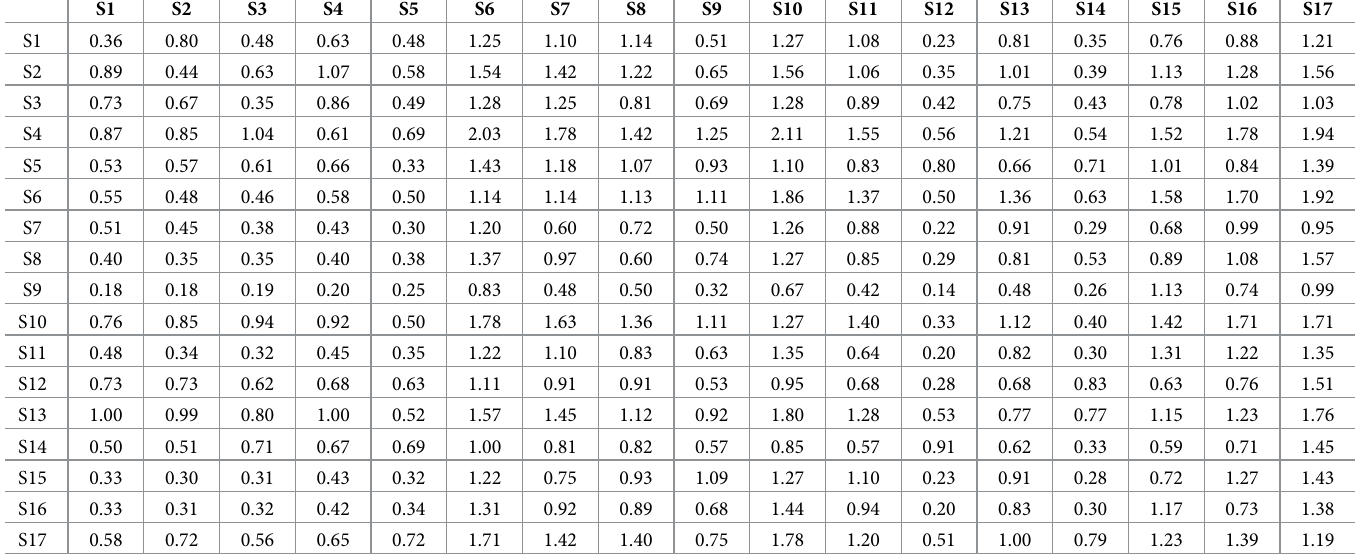
Table 9. The total relation matrix